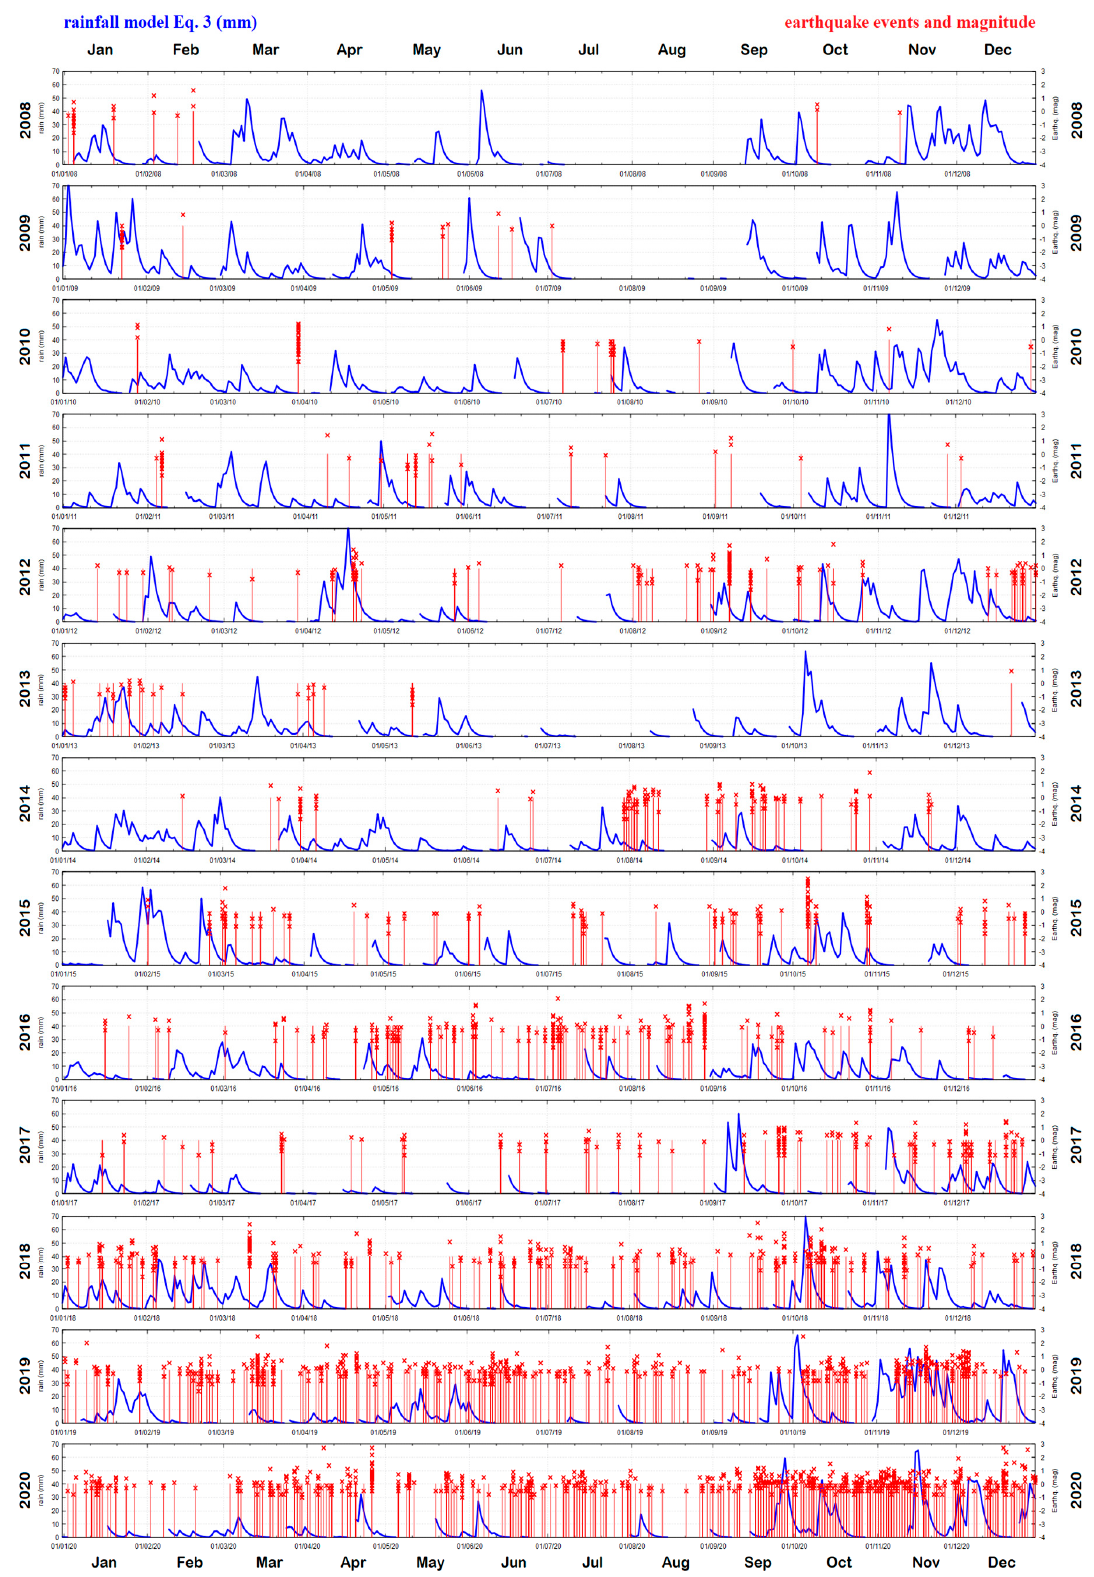
Figure 4. Scenario #3: R = 0.2 mm and τ = 2 day. Comparison between the empirical water stress-function (Equation (3)) estimated with the rainfall record of the Meteorological Observatory at San Marcellino in Naples (blue) and the seismic events at the Phlegraean Fields from 2008 to 2020 (red). Each panel covers one year. See Table 3.